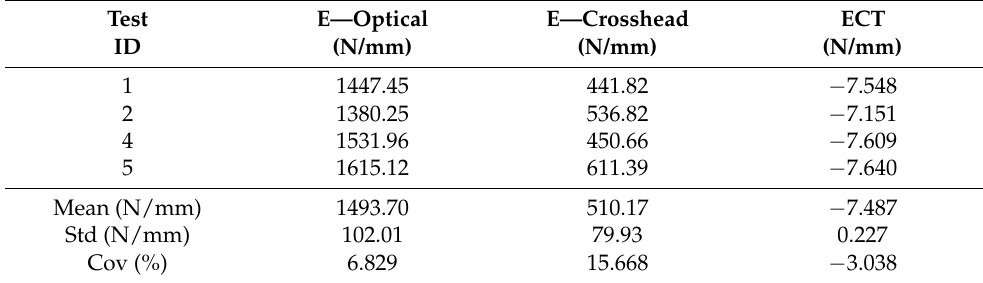
Table 3. Elastic stiffness index in CD computed from the displacement measurement by the optical extensometry and from machine crosshead, as well as the edgewise compression strength in CD.